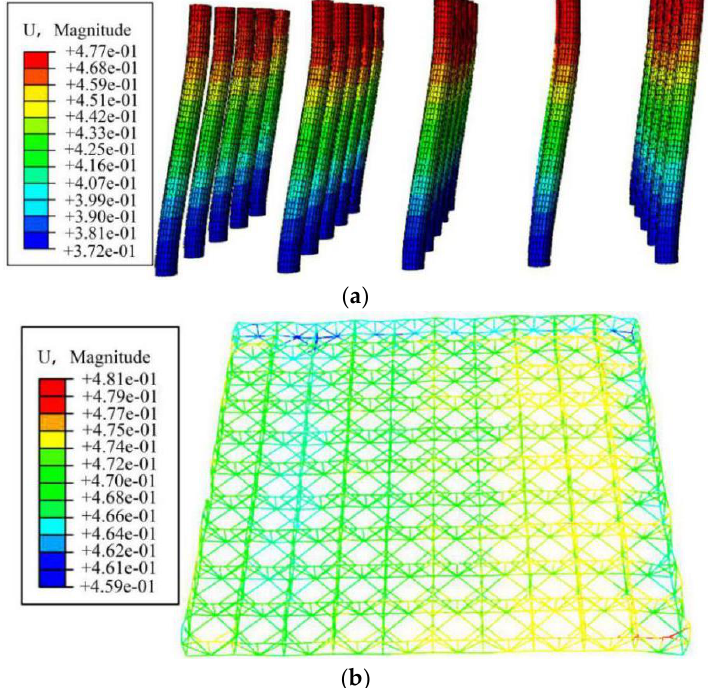
Figure 16. Displacement nephograms of RC tubular columns and the steel truss under the rare earthquake at the moment when the displacements reached the maximum values (unit: m; the deformation scale factor is 100): ( a ) Columns; ( b ) Truss.